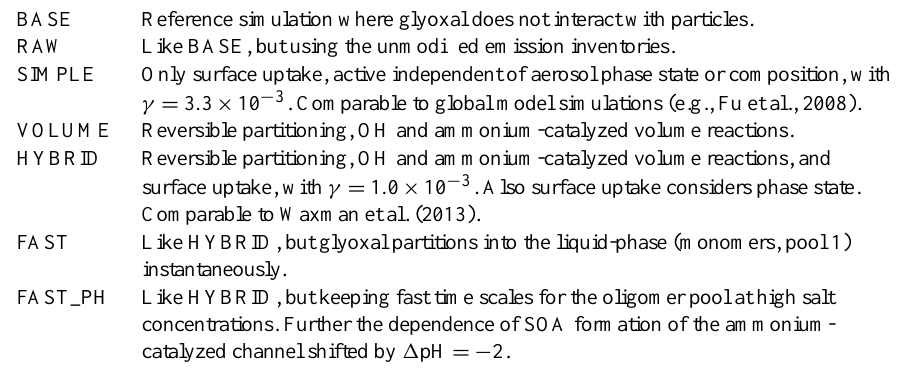
Table 6. List of simulations conducted. BASE Reference simulation where glyoxal does not interact with particles. RAW Like BASE, but using the unmodified emission inventories. SIMPLE Only surface uptake, active independent of aerosol phase state or composition, with γ = 3 . 3 × 10 − 3 . Comparable to global model simulations (e.g., Fu et al., 2008). VOLUME Reversible partitioning, OH and ammonium-catalyzed volume reactions. HYBRID Reversible partitioning, OH and ammonium-catalyzed volume reactions, and surface uptake, with γ = 1 . 0 × 10 − 3 . Also surface uptake considers phase state. Comparable to Waxman et al. (2013). FAST Like HYBRID, but glyoxal partitions into the liquid-phase (monomers, pool 1) instantaneously. FAST_PH Like HYBRID, but keeping fast time scales for the oligomer pool at high salt concentrations. Further the dependence of SOA formation of the ammonium- catalyzed channel shifted by 1 pH = −